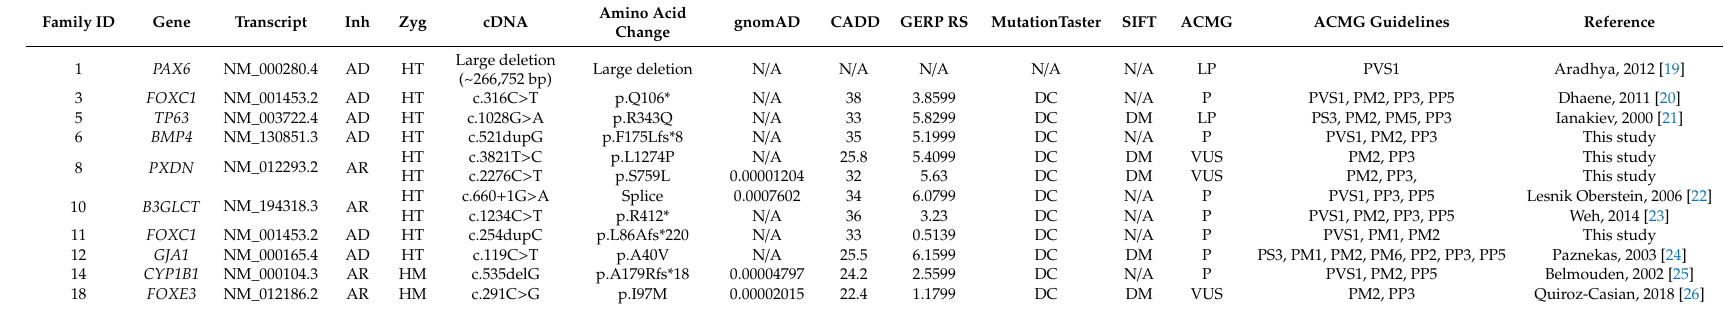
Table 1. Summary of the identified variants in this study.